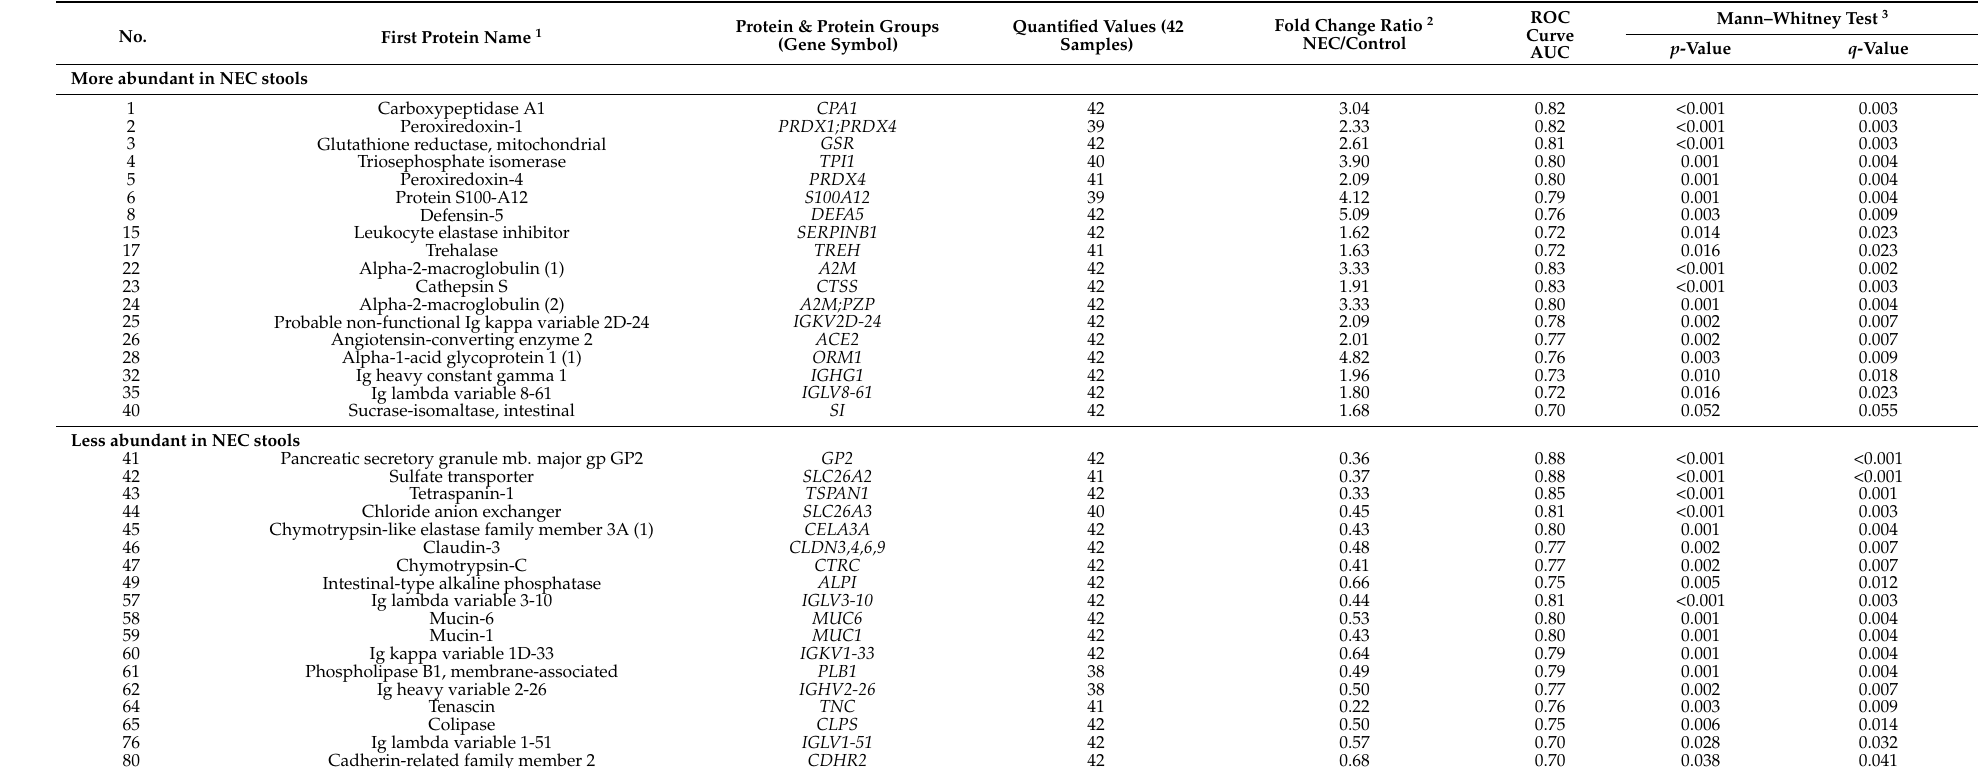
Table 4. Selection of the 36 series of increased and decreased protein